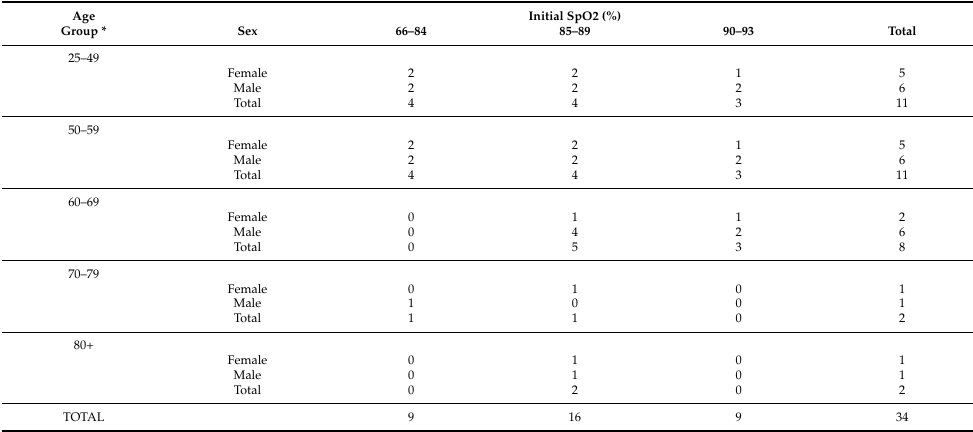
Table 1. Patient age group, sex, and range of pre-treatment SpO2